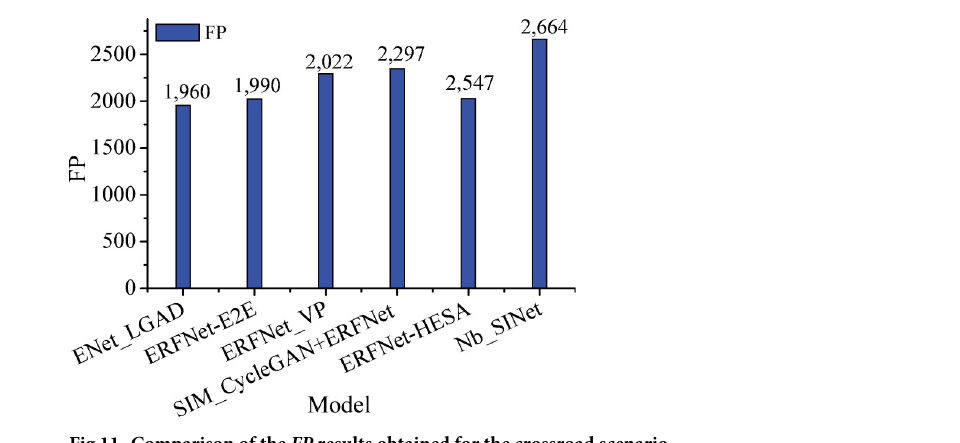
PLOS ONE | https://doi.org/10.1371/journal.pone.0252755 October 19,